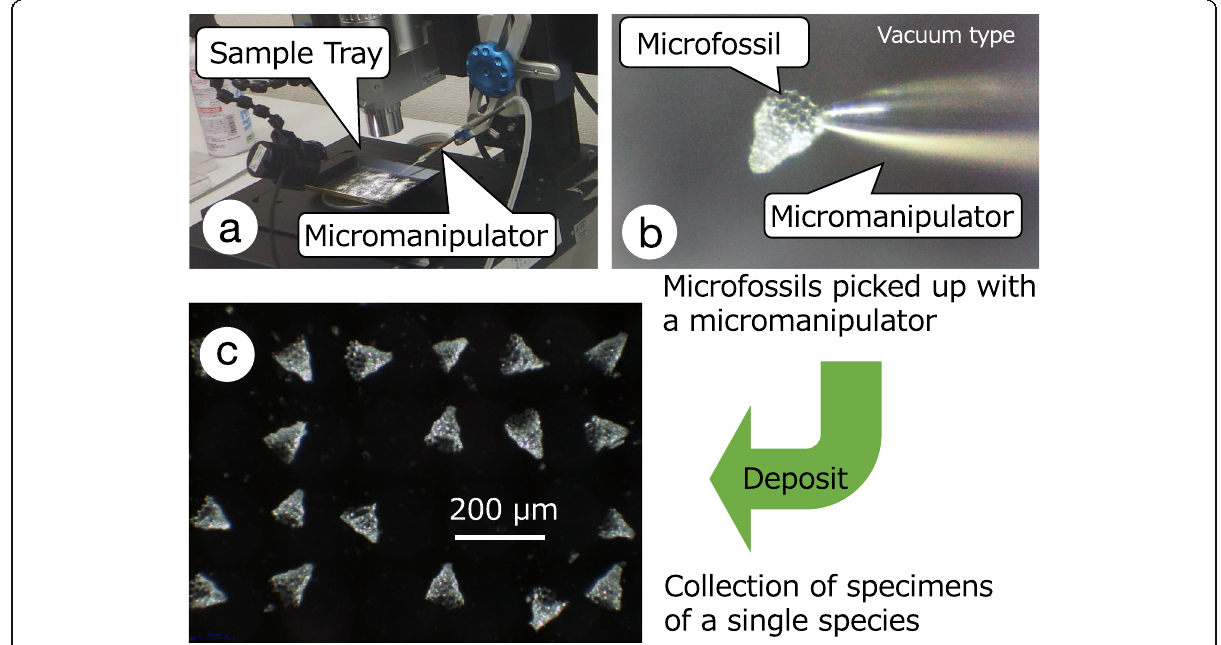
Fig. 2 Photographs showing microfossil pick-up and collection. a Microfossils are picked up using the micromanipulator from among various particles scattered on a specially designed sample tray. b An extracted microfossil ( Cycladophora davisiana ) gripped at the tip of the vacuum-type micromanipulator. c The assemblage of C. davisiana collected on an adhesive sheet. Scale equals 200 μ